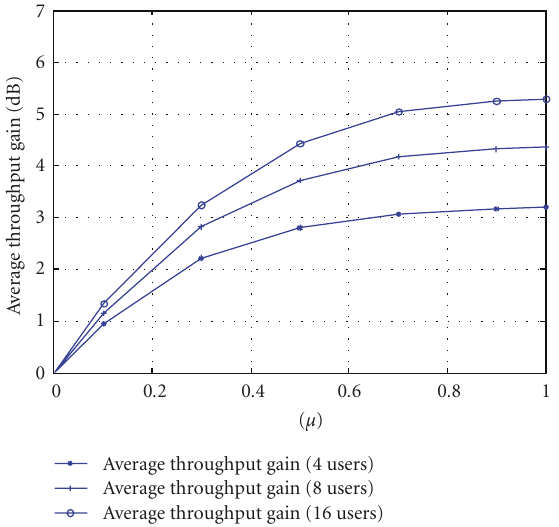
Figure 5: Throughput gain with respect to threshold level (4, 8, and 16 users per BS